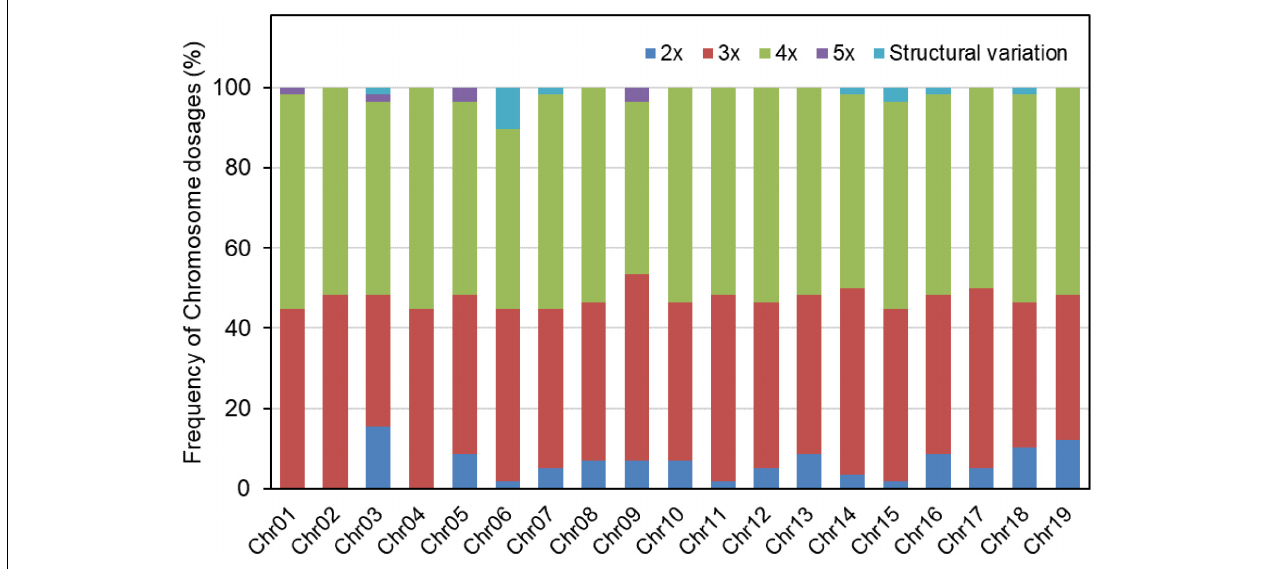
FIGURE 3 | Frequency of each chromosome dosage and occurrence of structural variations in the progeny of TB03 ×